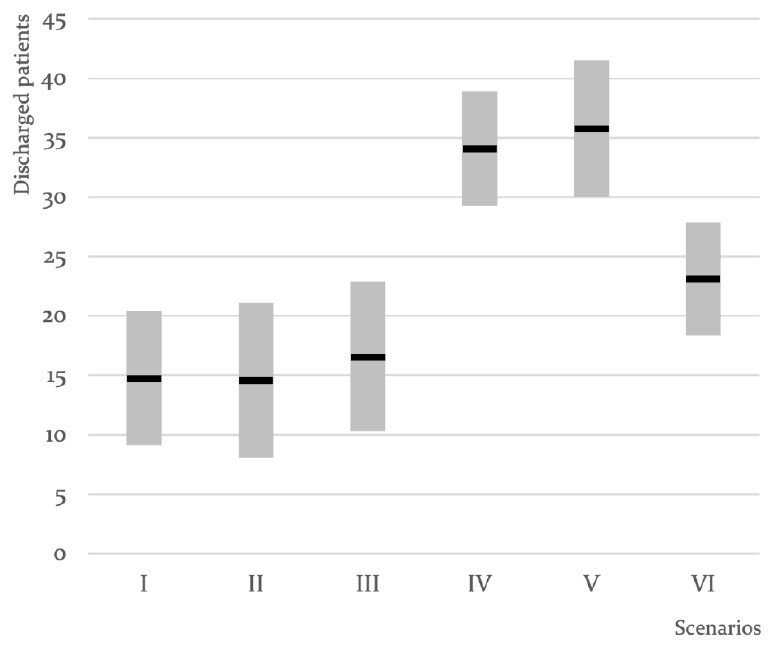
Figure 4 . A chart illustrating the mean and the confidence interval (95% confidence level) of the number of patients discharged (total and per round), including regular discharge and referrals to external GPs, for all the different strategies. Strategies I, II, III, and VI—traditional; strategies IV and V—TOC.